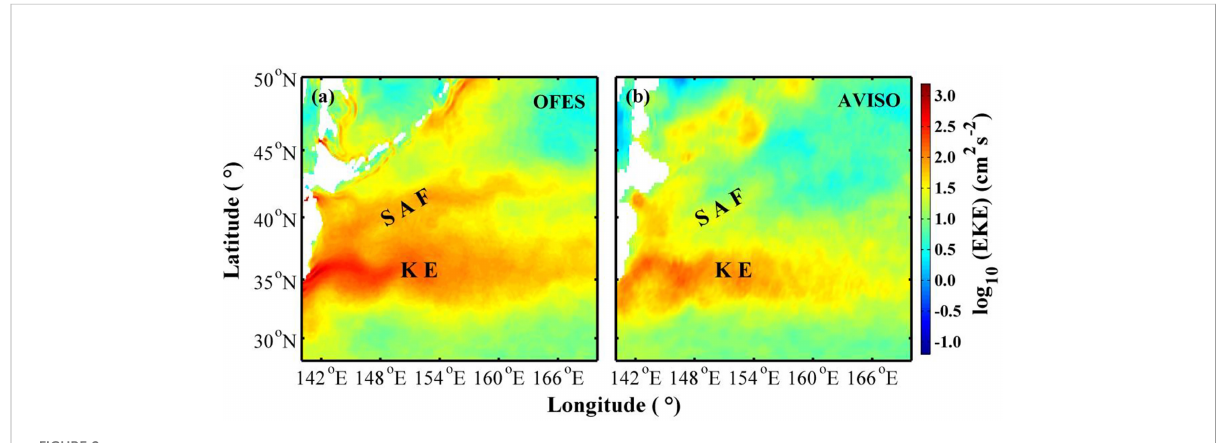
FIGURE 2 Distribution of sea surface eddy kinetic energy calculated from (A) OFES and (B) AVISO data. Shading indicates the value of eddy kinetic energy (units: cm 2 /s 2 ). The symbol “ KE ” and “ SAF ” represent the Kuroshio Extension and Subarctic Front, respectively. Note that the eddy kinetic energy is plotted with log base